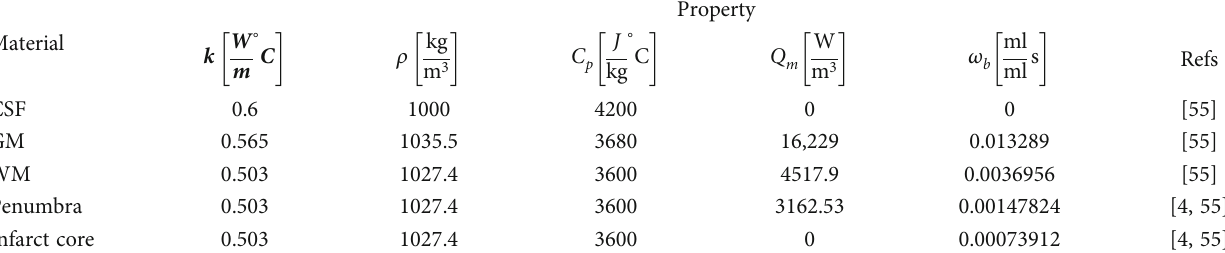
Table 1: Thermophysical properties of the brain and acute ischemic stroke tissues. Material